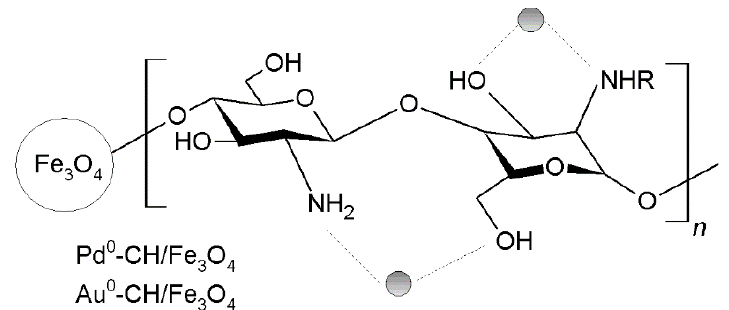
Figure 19. Magnetic chitosan based catalysts loaded with Pd 0 or Au 0 used in the oxidative Figure19. MagneticchitosanbasedcatalystsloadedwithPd 0 orAu 0 usedintheoxidativehomocoupling homocoupling of phenylboronic acid. of phenylboronic acid.